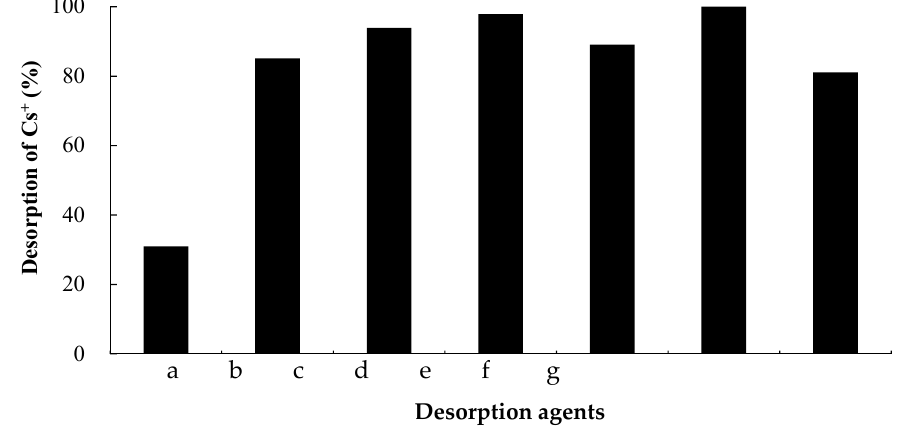
Figure 6. Desorption ratio (%) of Cs + from JB-1a (0.5 g) using 0.1 mol/L solutions of different salts. a: H 2 O, b: HCl, c: (NH 4 ) 2 HPO, d: NH 4 Cl, e: NH 4 F, f: (NH 4 ) 2 C 2 O 4 , and g: Ethylenediaminetetraacetic acid